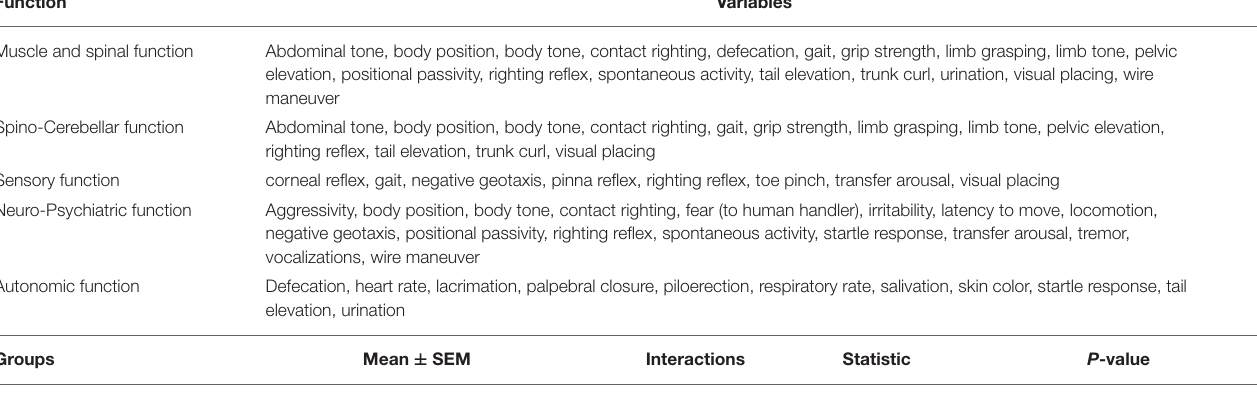
TABLE 2 | Five functions were evaluated in the observational screen.